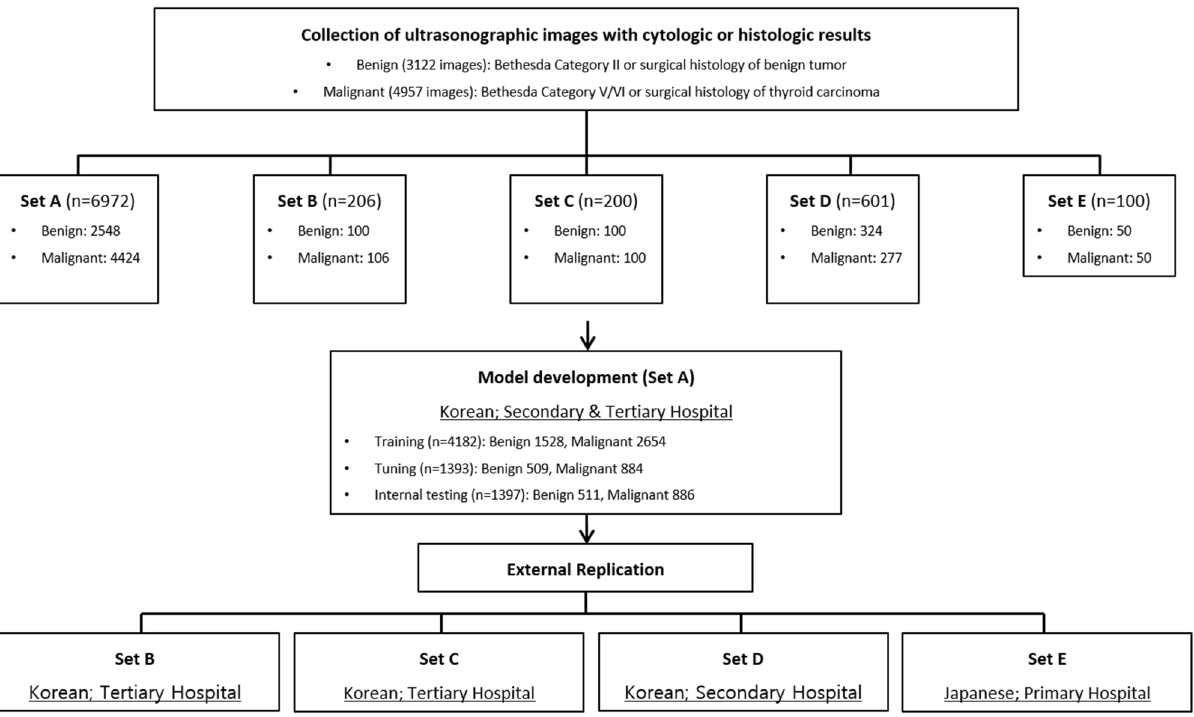
Figure 1. Flow chart of data collection and